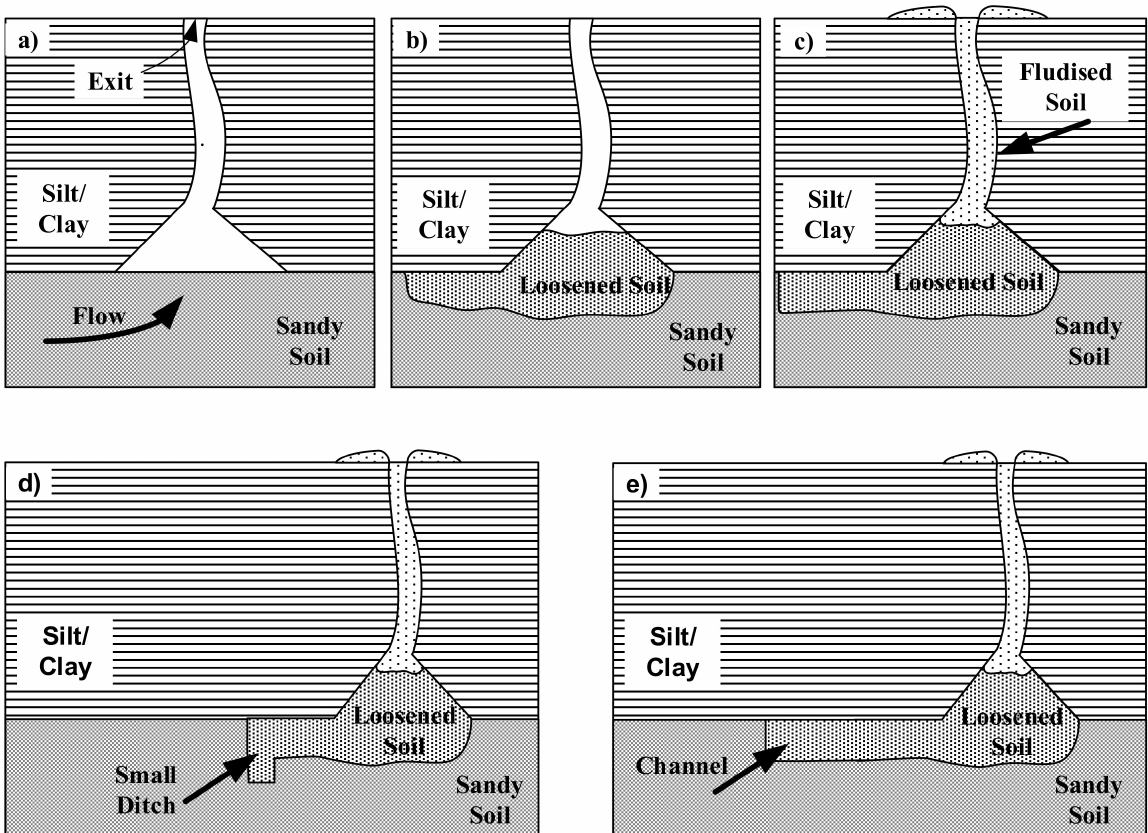
Figure 7. Schematic illustration of the erosion development of